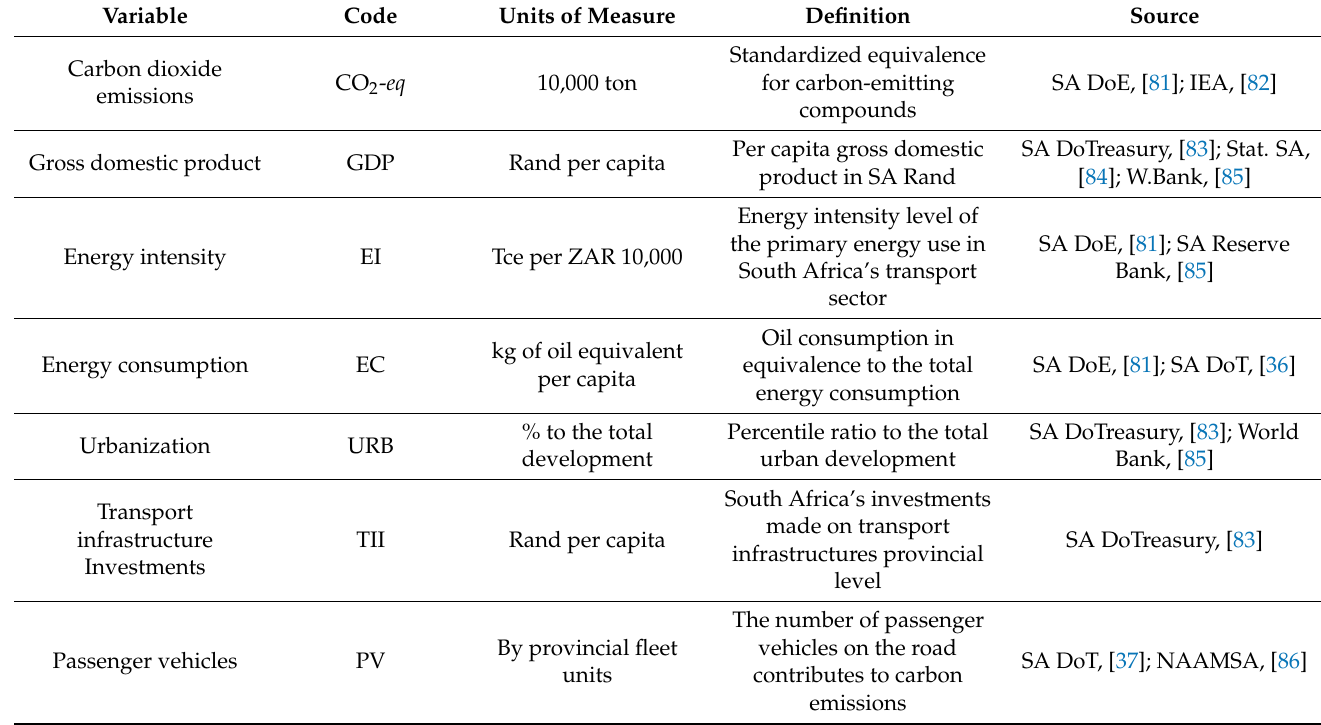
Table 2. Definition of variables represented with their codes and units of measurement.